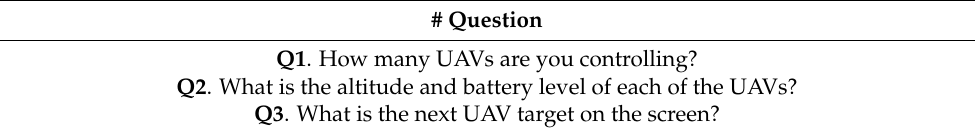
Table 1. Questions asked during the test to assess operator situational